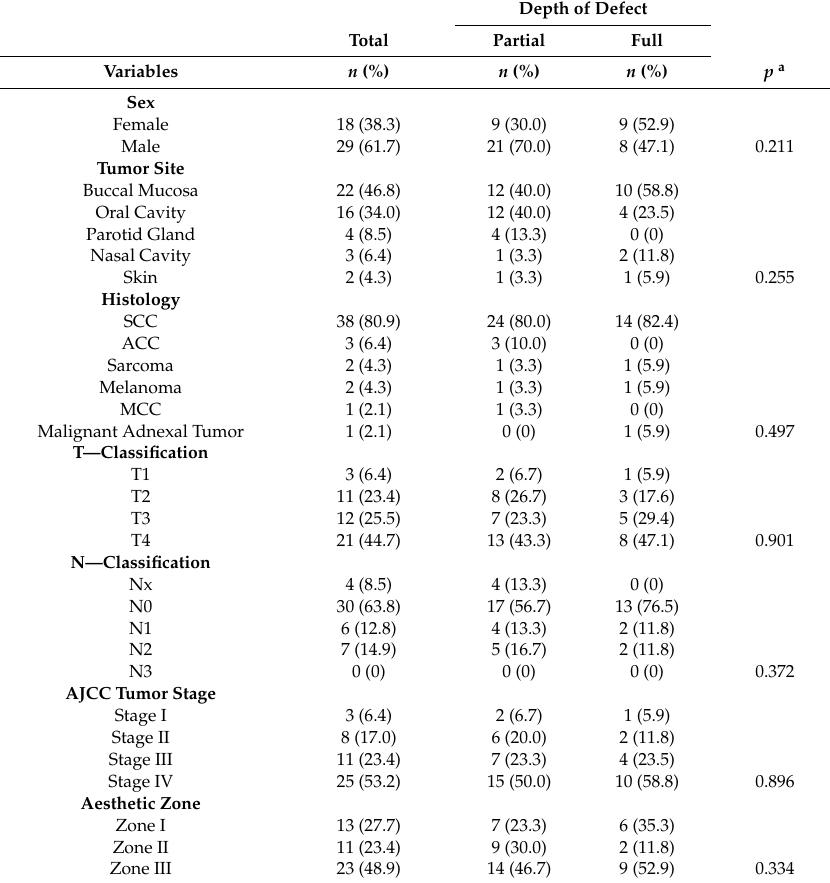
Table 1. Patient